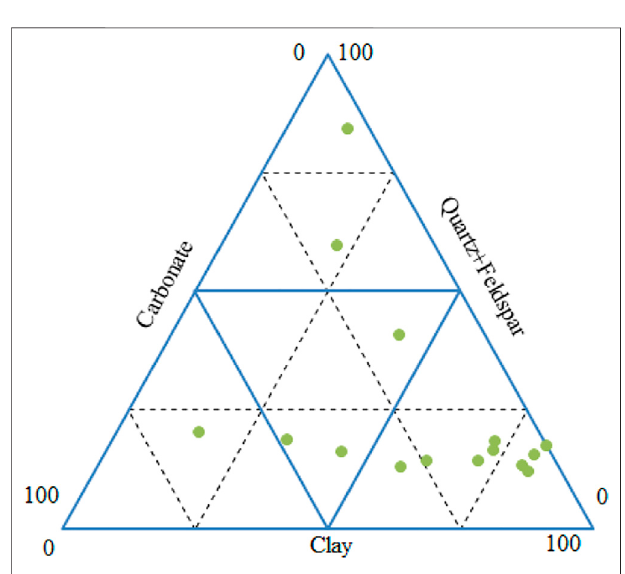
FIGURE 2 | Distribution of mineral component content of samples in the study